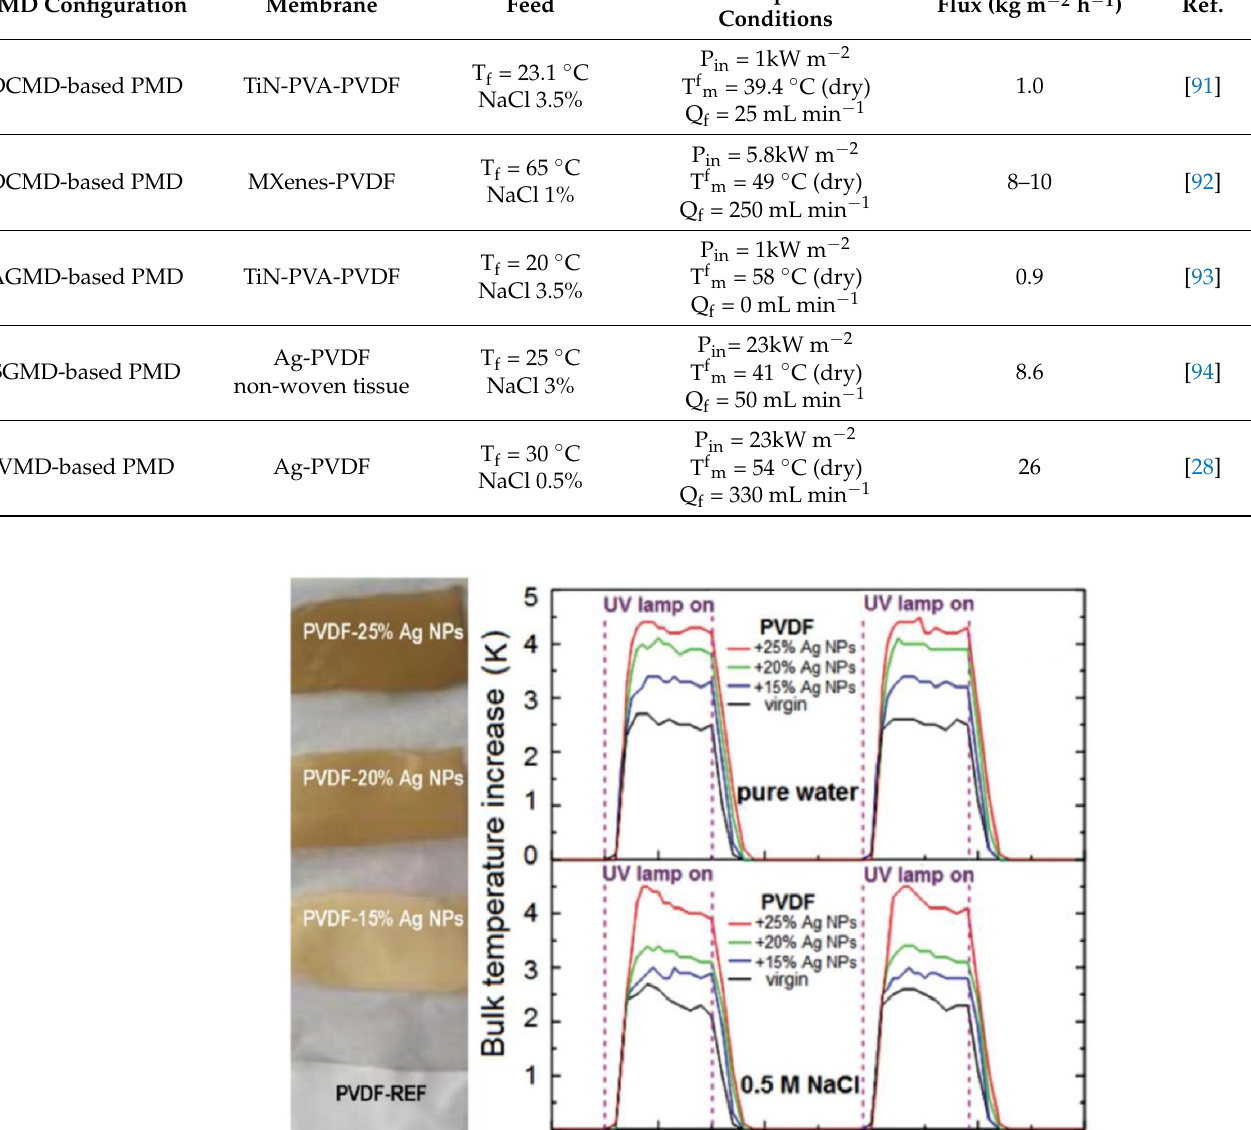
Figure 5. Prototype equipped with a solar panel to provide electric power for the feed and permeate/vacuum pump in PVMD ( a ). Membrane modules employed in lab activities for experiments of PVMD ( b ), PDCMD or PSGMD ( c ). Scheme of a membrane module for PAGMD ( d ). Reproduced with permission from Ref. [43]. Copyright 2022 Royal Society of Chemistry.